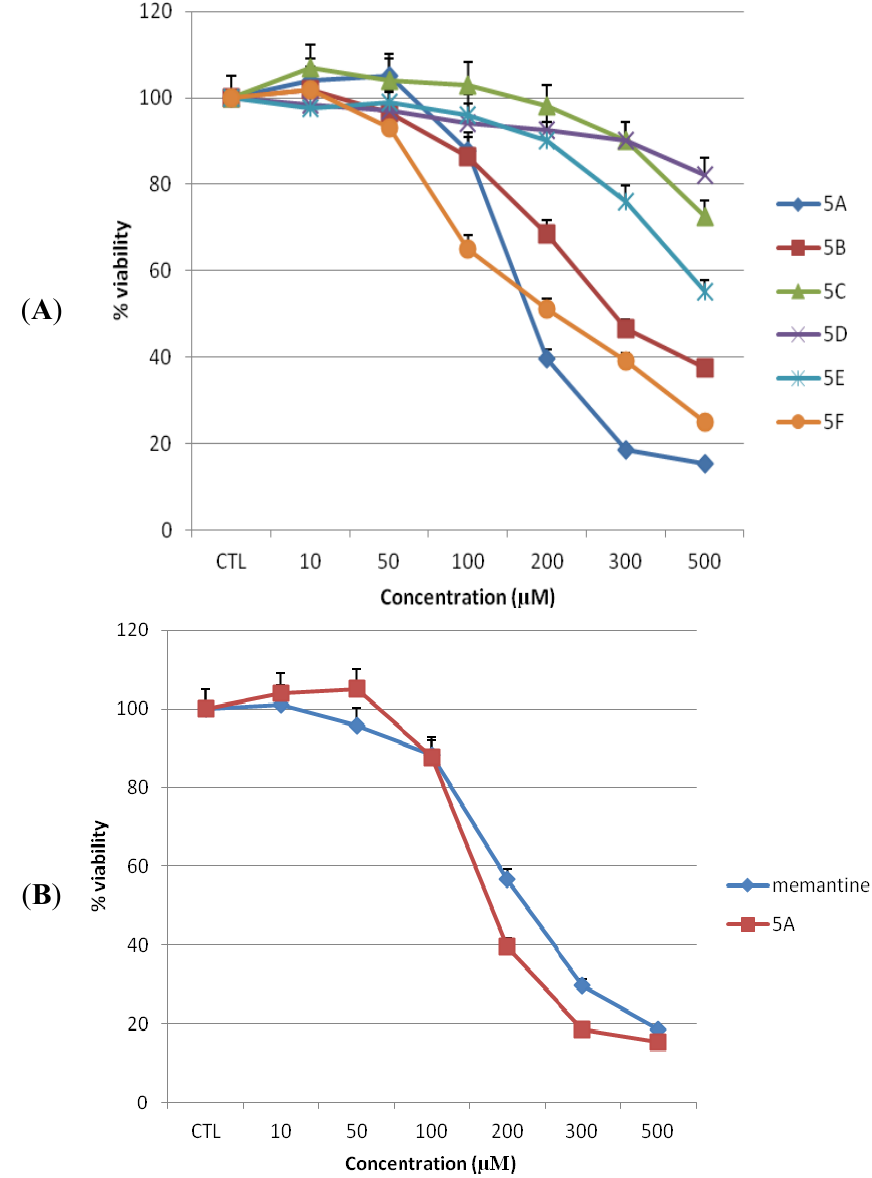
Figure 2. Toxicity of novel NMDA receptor antagonists and memantine on MDCK cells. Toxicity (as the percentage of untreated control) was measured by MTT assay after 24 h of treatment (n = 3). ( A ) Novel NMDA receptor antagonists, 5a – f . ( B ) Lead compound 5a and memantine. All data represent mean ±